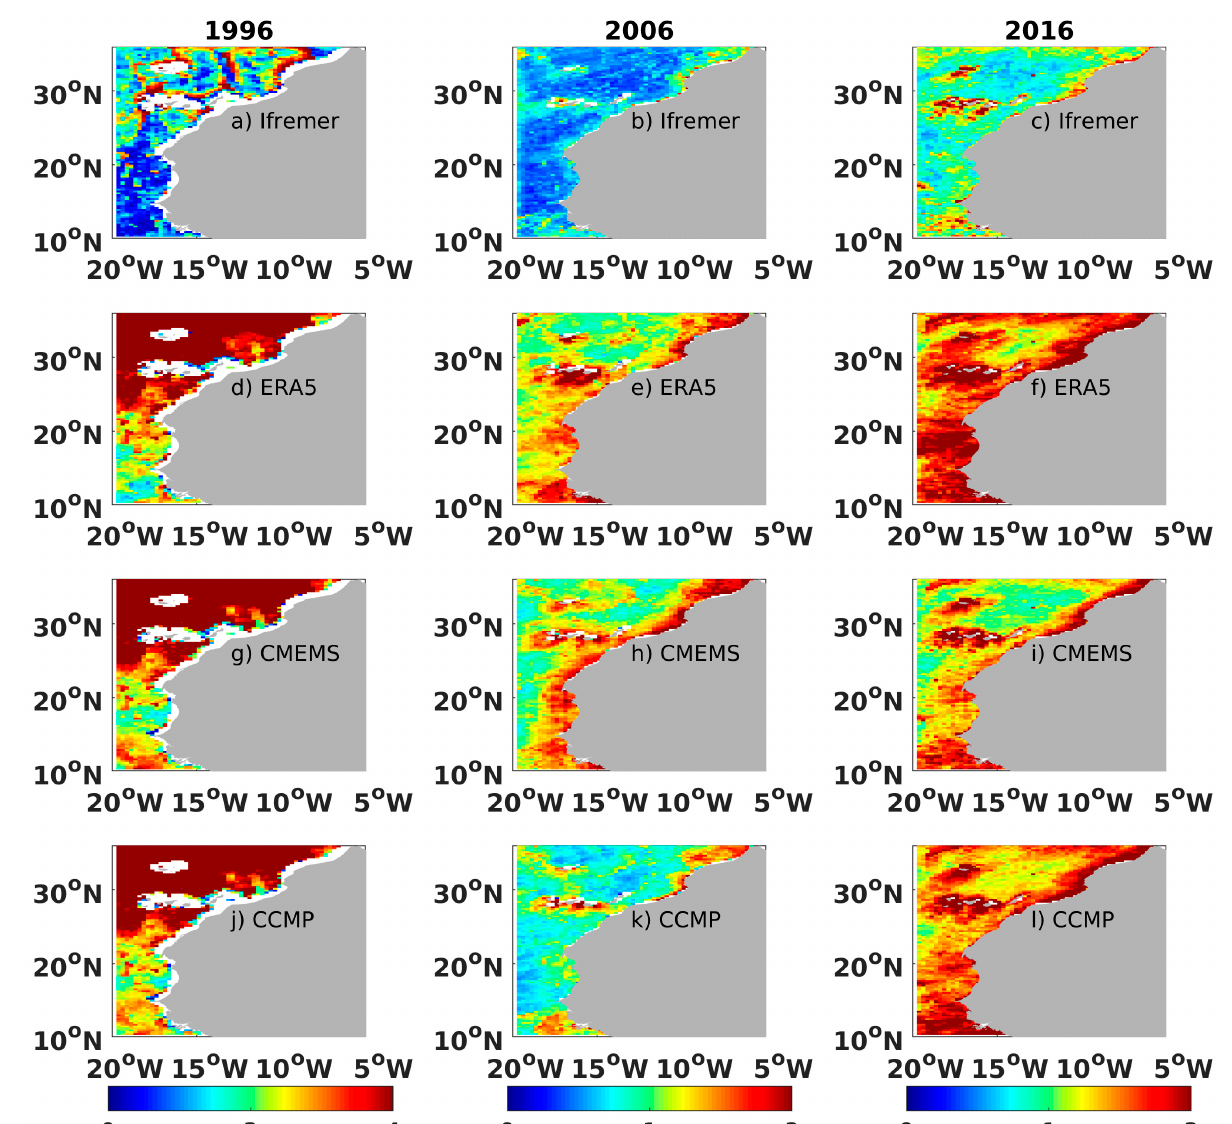
Figure A5. Spatial distributions of root mean square of meridional wind component differences between collocated scatterometer retrievals and satellite wind analyses, referenced as Ifremer, ( a – c ), ERA5 wind estimates ( d – f ), CMEMS winds ( g – i ), and CCMP winds ( j – l ). The results are drawn from data occurring, over Canary zone, in 1996 (panels in left column), 2006 (middle column), and 2016 (right column). Color indicates RMSD values in m/s. One should notice that the color bar associated with 1996 is different from the 2006 and 2016 ones.